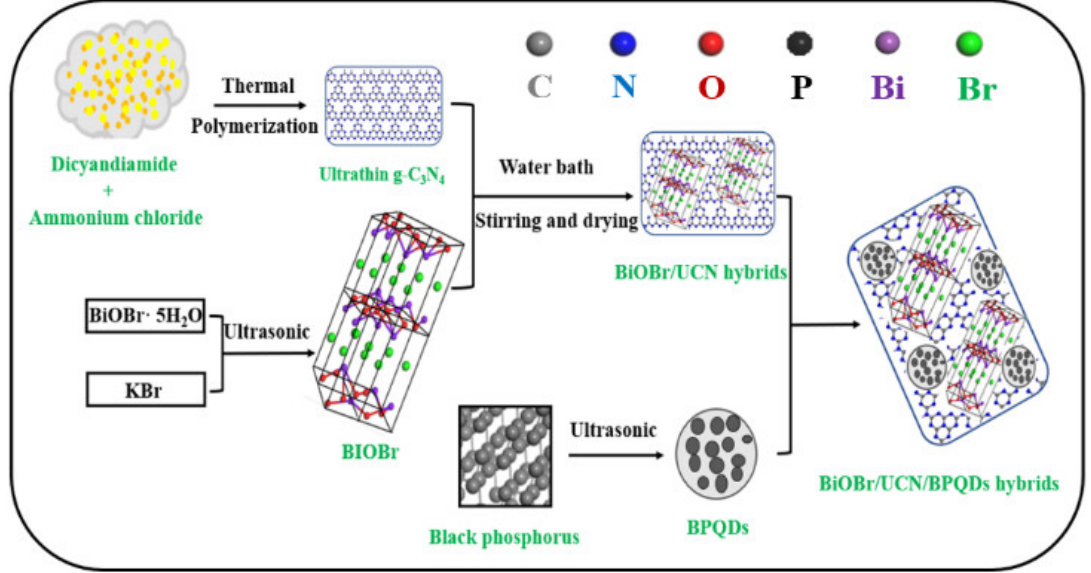
Figure 1. Schematic route of the production of BiOBr/UCN/BPQDs hybrids.